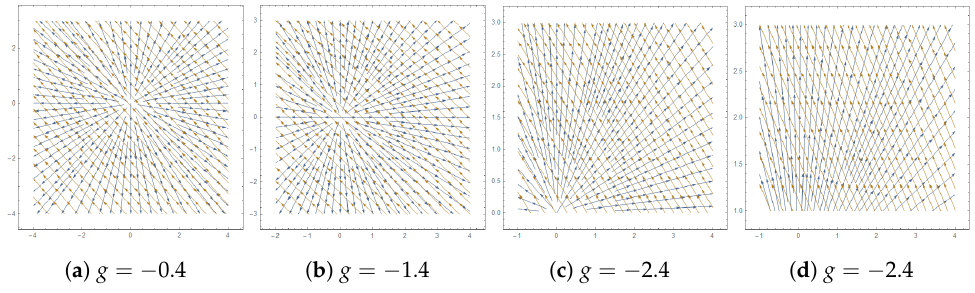
Figure 19. Stream plots corresponding to Figure